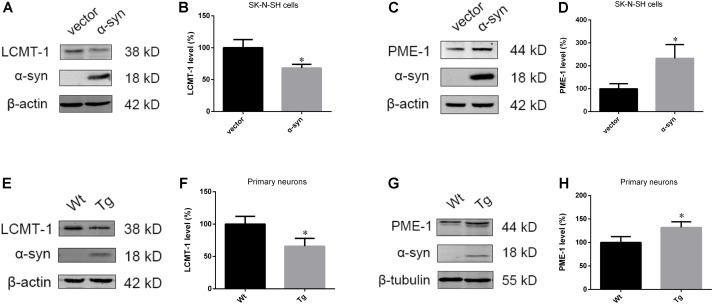
α-syn overexpression downregulated LCMT-1 while upregulating PME-1 in vitro. (A–D) The expression of LCMT-1 and PME-1 was determined with western blotting in cells transfected with pCMV-Myc or pCMV-Myc-α-syn. β-actin was used as a loading control. The ratio of LCMT-1 or PME-1 expression to β-actin in vector group was considered as 100%. (E–H) Western blot analysis of LCMT-1, PME-1 and α-syn in α-syn-overexpressing neurons and controls. β-actin and β-tubulin were used as loading controls. The ratio of LCMT-1/β-actin or PME-1/β-tubulin in vector group was considered as 100%. Data are expressed as mean ± SD. KS test; P > 0.05; F-test; P > 0.05; unpaired Student’s t-test; ∗P < 0.05 vs. vector or Wt primary neurons (n = 3).